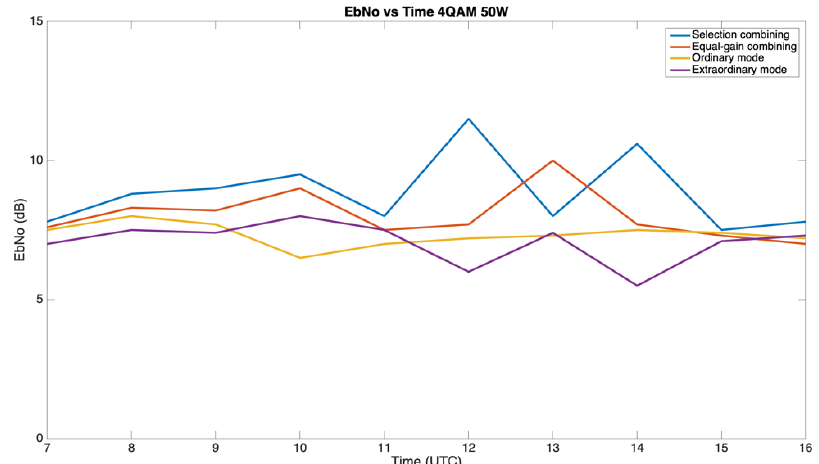
Figure 14. Received bit energy-to-noise power spectral density (E b /N 0 ) for the 4QAM modulation at 50 W throughout the day.